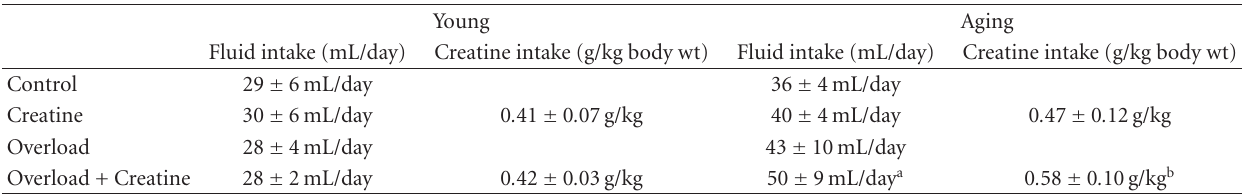
Table 1: Fluid consumption and creatine intake for young and aging rats.